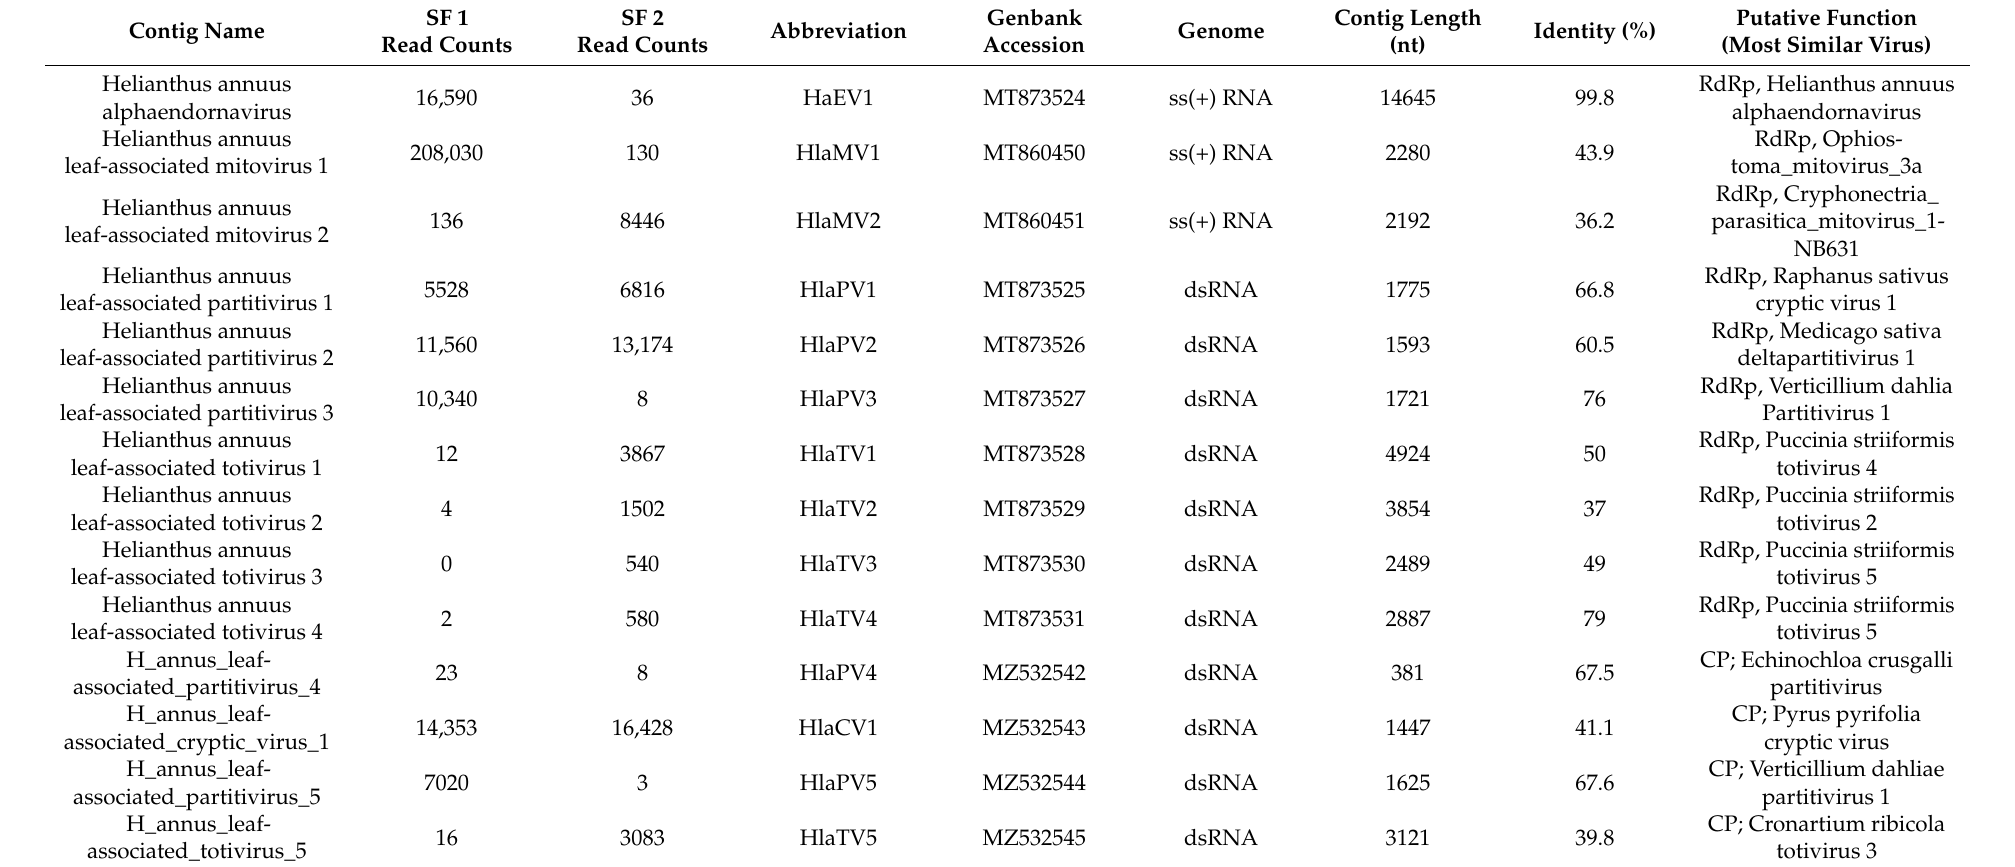
Table A1. Novel mycoviruses discovered by metatranscriptomics approach from sunflower (RdRp: RNA-dependent RNA polymerase). The SF1 library was constructed from RNA extracts of phomopsis-infected leaves, while the SF2 library was constructed from rust-infected